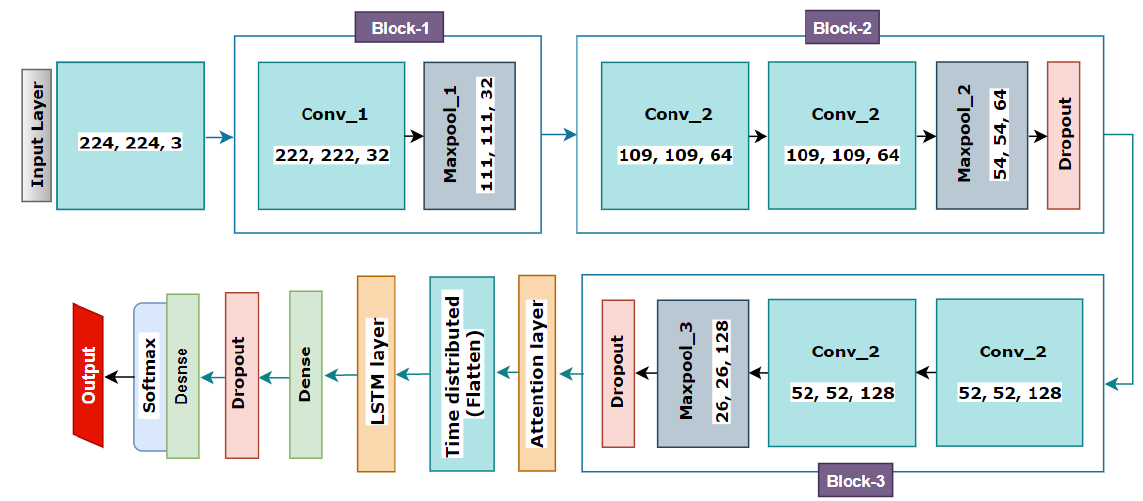
Figure 28. Proposed CNN model modified with attention mechanism and LSTM.